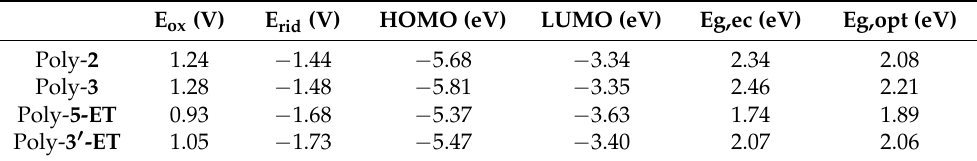
Figure 5. Cyclic voltammetry characterization of poly − 2 ( a ), poly − 3 ( b ) and poly − 5 − ET ( c ) in CH 3 CN/TEAPF 6 0.1 solution. Table 4. Voltammetric data in CH 3 CN/TEAPF 6 0.1 M and UV-Vis data of the polymer